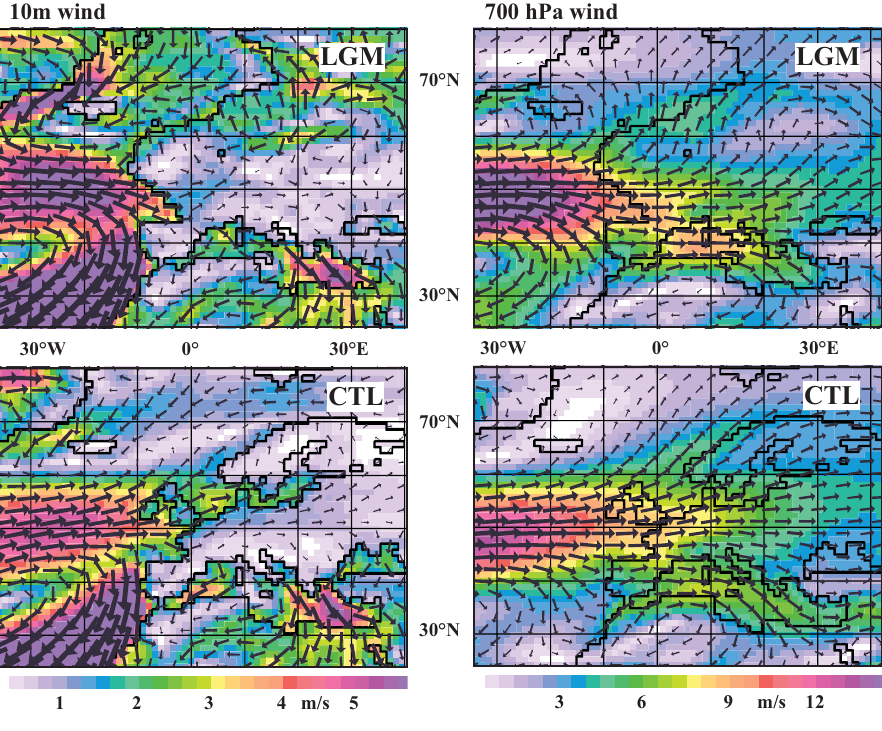
Fig. 10. Simulated summer (JAS) winds from the atmosphere model in m / s. The left panels show the near-surface winds, the right panels the wind at 700hPa. The top panels show LGM, the bottom CTL. The data have been averaged over 20 model years.